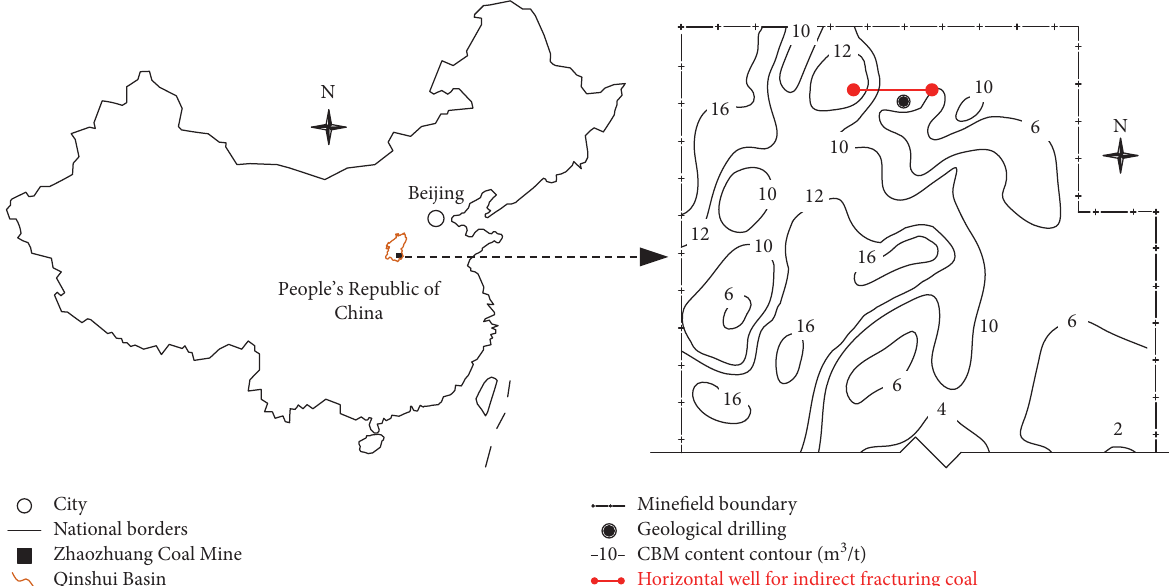
Figure 1: Location of Zhaozhuang mine and CBM occurrence environment.